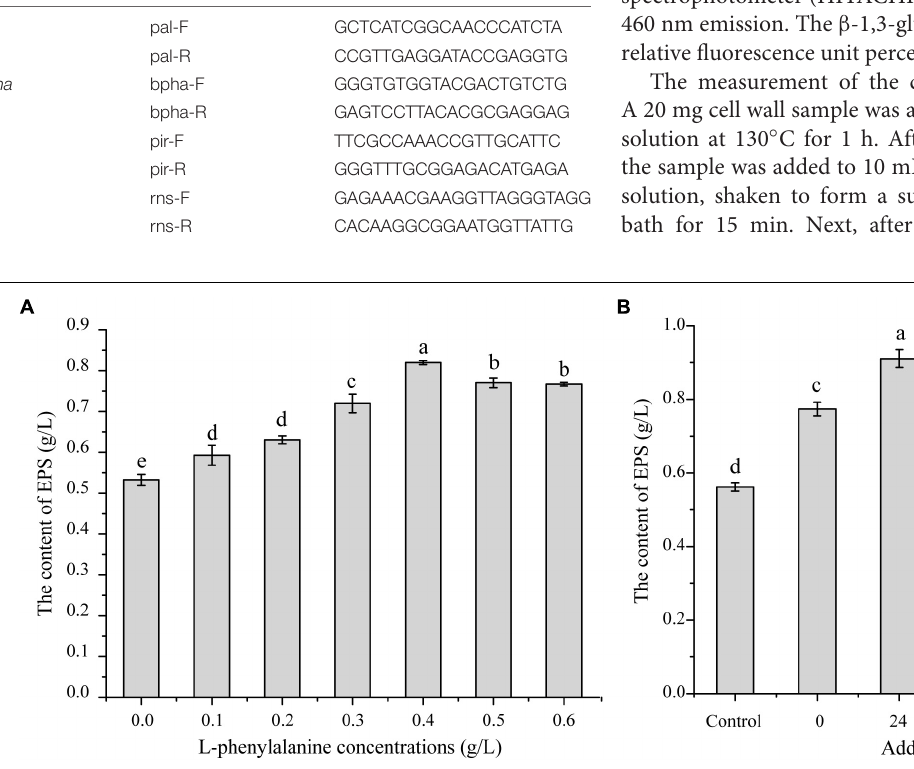
Frontiers in Microbiology |